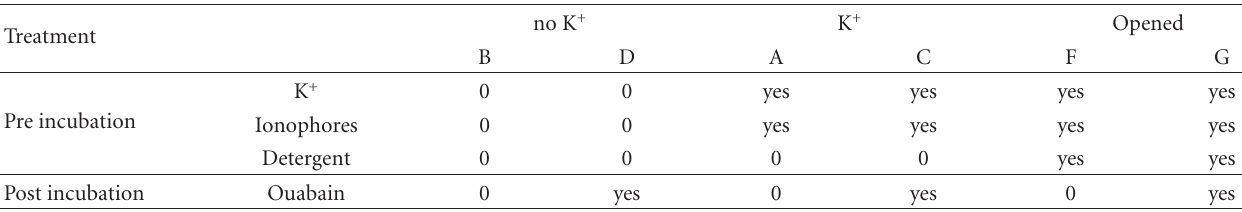
Table 1: Outline of treatments included in the sidedness assay. One batch of proteoliposomes was prepared and split into 6 × 400 μ l aliquots, each aliquot preincubated (2 minutes, room temperature) with reagents indicated, then 0 or 3 mM ouabain added, and samples incubated with ATP (60 minutes; 37 ◦ C). Adapted from